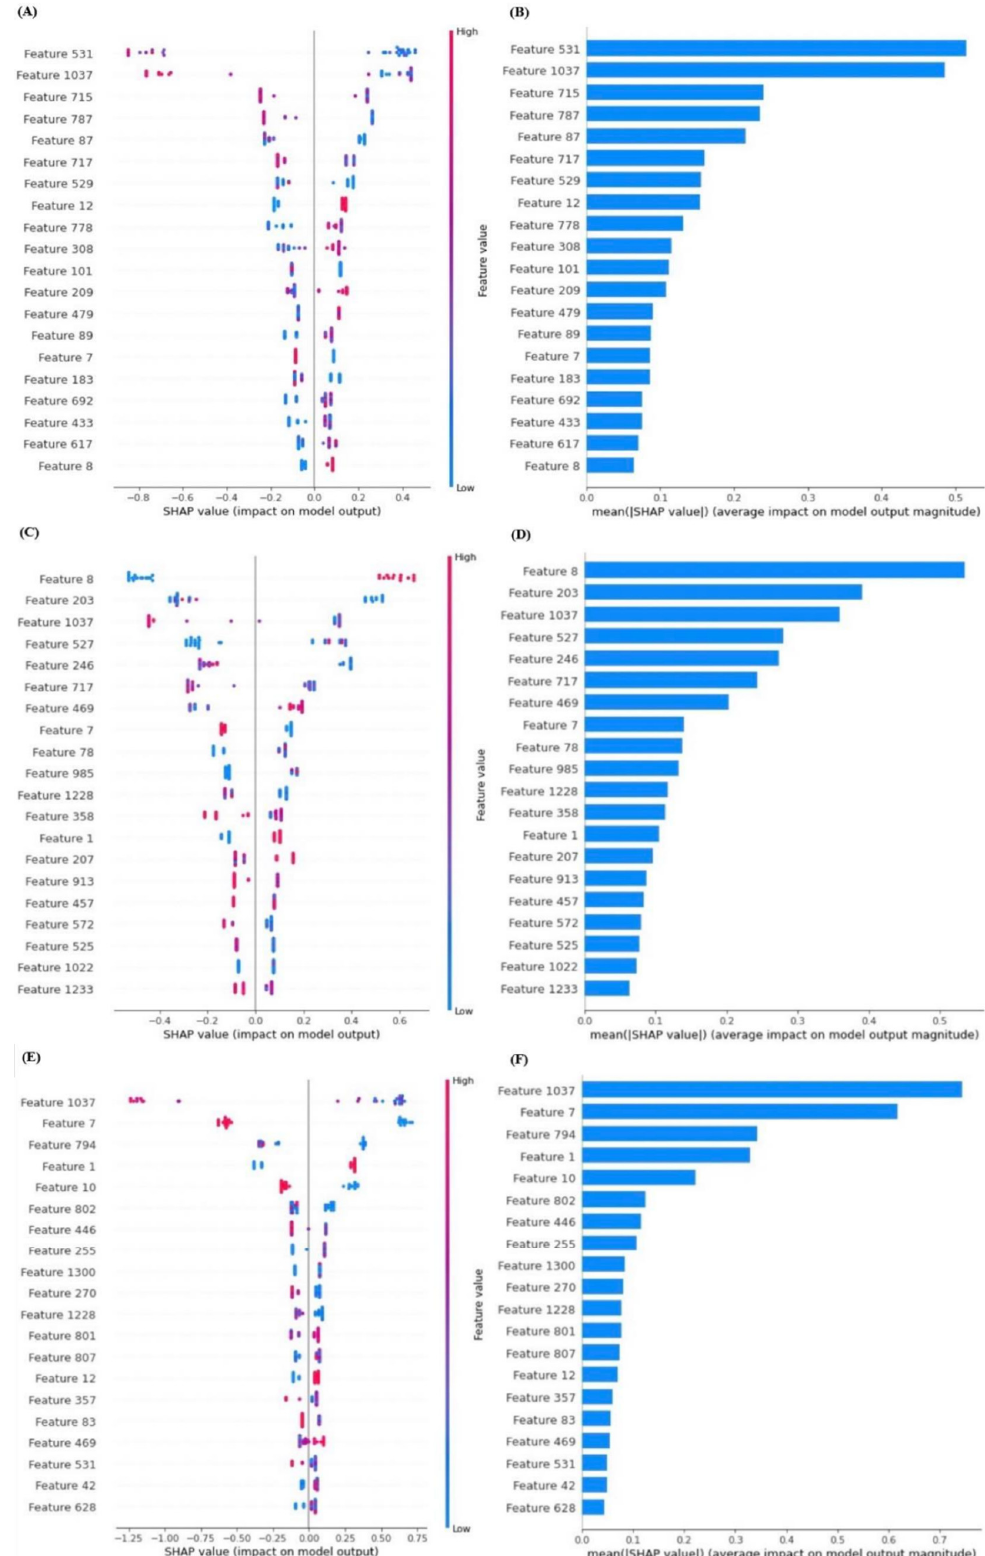
Figure 8. The feature importance of the XGBoost model after predicting neck recurrence. The feature names can be found in Table A1. ( A ) The SHAP value of the first model ( B ) The mean SHAP value of the first model ( C ) The SHAP value of the second model ( D ) The mean SHAP value of the second model ( E ) The SHAP value of the third model ( F ) The mean SHAP value of the third model.